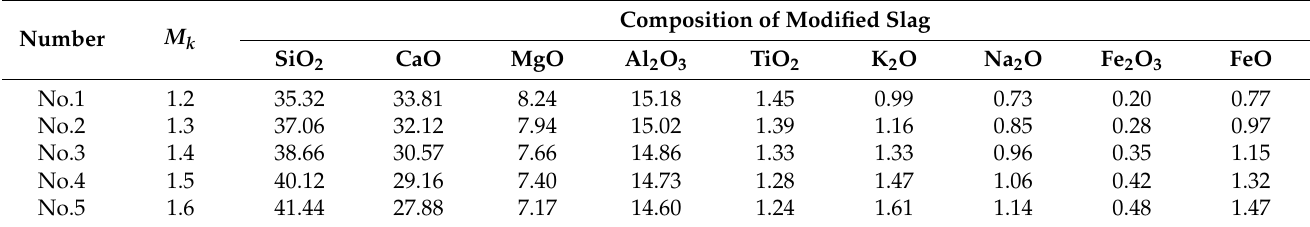
Table 2. Chemical composition of modified blast furnace slag/wt.%.